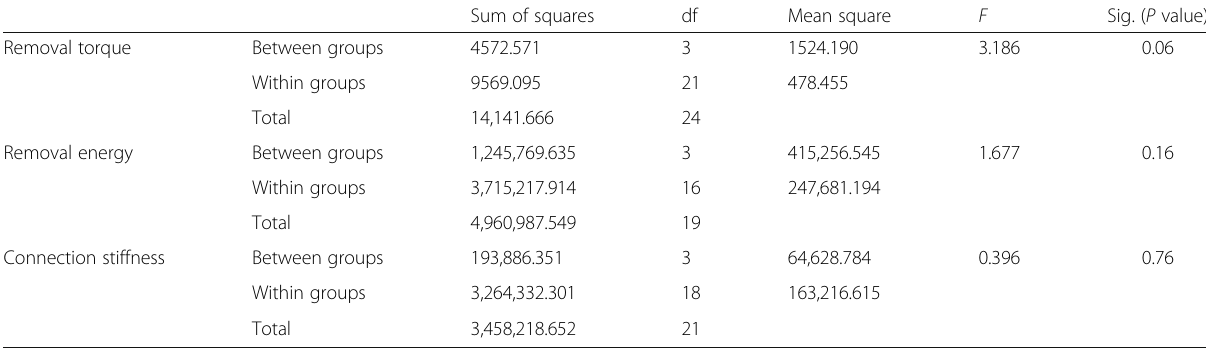
Table 1 One-way ANOVA variance and Tukey ’ s post hoc test values of removal torque (N cm), removal energy [N cm/rad (0.01 J)], and connection stiffness [N cm/rad] for SAE-HD and SAE implants at 2 and 4 weeks postoperatively ( n = 6; P < 0.05)